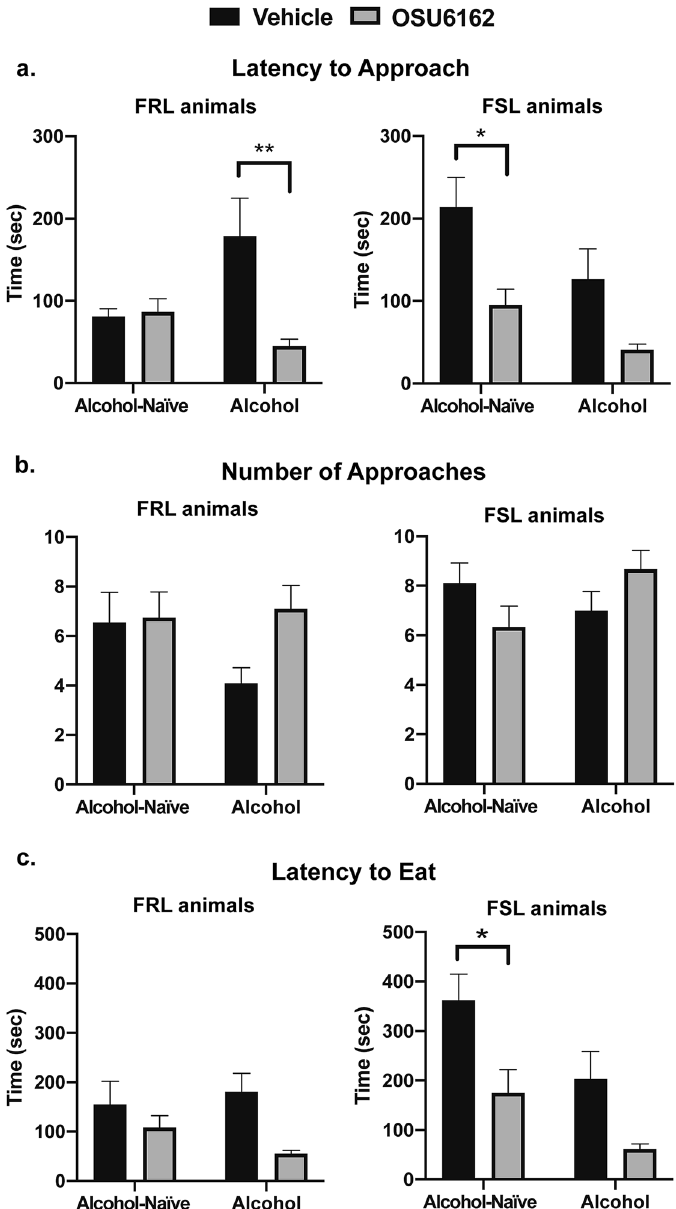
Figure 5. OSU6162 has anxiolytic-like properties. The Novelty Suppressed Feeding (NSF) test was used to evaluate the effects of the monoamine stabilizer OSU6162 (OSU) on anxiety-like behaviors in long-term alcohol drinking and alcohol-naïve rats from the FSL and their controls FRL. The NSF test 3 was repeated twice to allow all animals to receive both treatments: OSU (30 mg/kg) or vehicle (saline); see also schematic experimental timeline (Fig. 1). Treatments were administered subcutaneously 60 min before the NSF test and the rats were randomized to receiving either OSU or vehicle at the first test occasion. ( a ) In control FRL animals, OSU had a significant main effect on latency to approach the food and interacted with alcohol exposure, and post-hoc assessments showed a significant difference in latency between OSU and vehicle in the alcohol group (n = 8–9 animal pairs/group; n = 1 outlier). In FSL animals, both alcohol exposure and OSU administration had significant main effects on the latency to approach the food, and post-hoc assessments showed a significant difference in latency between OSU and vehicle in the alcohol-naïve group, and a close-to-significant difference in the alcohol group (n = 8–9 animal pairs/group; n = 1 outlier). ( b ) OSU had no significant effect on the number of approaches in controls (n = 8–10 animal pairs/group) or in FSL animals (n = 9 animal pairs/group). ( c ) In controls, OSU had a significant main effect on the latency to eat the food, with post-hoc assessments revealing a close-to-significant difference between OSU and vehicle in the alcohol group (n = 3–6 animal pairs/group; n = 1 outlier). In addition, in FSL animals, both alcohol exposure and OSU administration had significant main effects on latency-to-eat, with post-hoc assessments showing a significant difference in latency between OSU and vehicle in the alcohol-naive group, and a trend in the alcohol group (n = 7–8 animal pairs/group; n = 1 outlier). Graph data are presented as mean ± SEM and were analyzed by mixed-effects models followed by Sidak’s multiple comparisons test. *P < 0.05, **P <